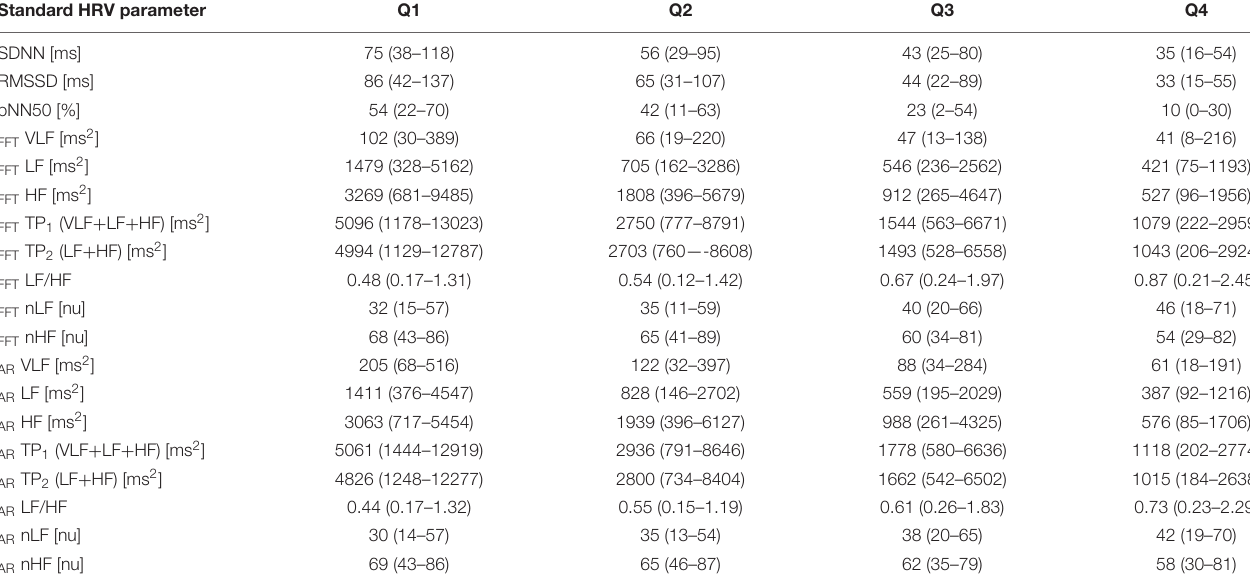
FFT denotes that a given HRV parameter was calculated by using Fast Fourier Transform, while AR indicates that the HRV spectrum was calculated with autoregressive method. HR quartiles for overall study group: (Q1), 54.7–77.8 bpm; (Q2), > 77.8–84.3 bpm; (Q3), > 84.3–92.0 bpm; (Q4), > 92.0–113.8 bpm.